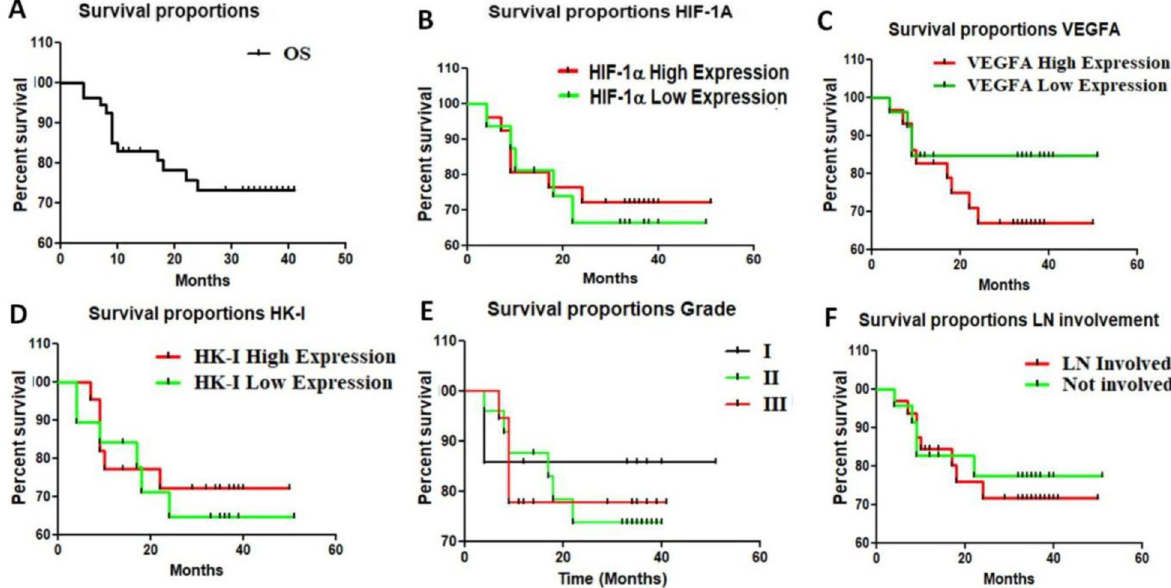
Fig. 7 Kaplan–Meier plots depicting overall survival (OS) in breast cancer ( A ) OS in BC patients ( B ) Survival analysis correlating expression to overall survival HIF-1α ( C ) VEGFA ( D ) HK-I ( E ) Survival analysis correlating expression to the histological Grade ( F ) Survival analysis correlating expression to Lymph Node